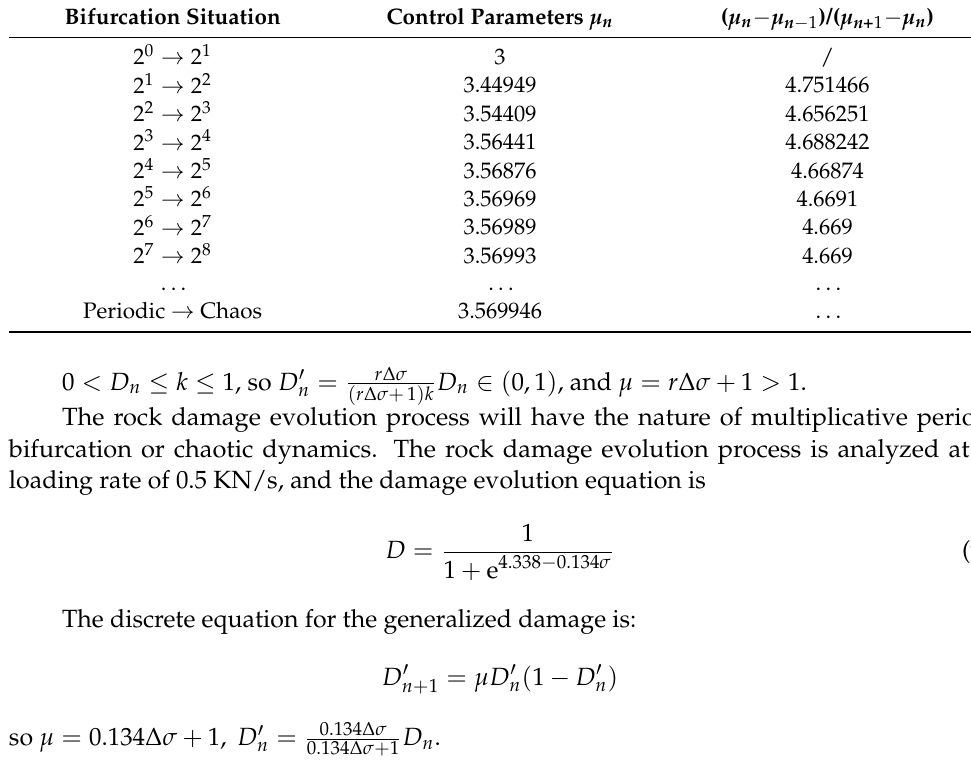
Table 2. Logistic mapping bifurcation point